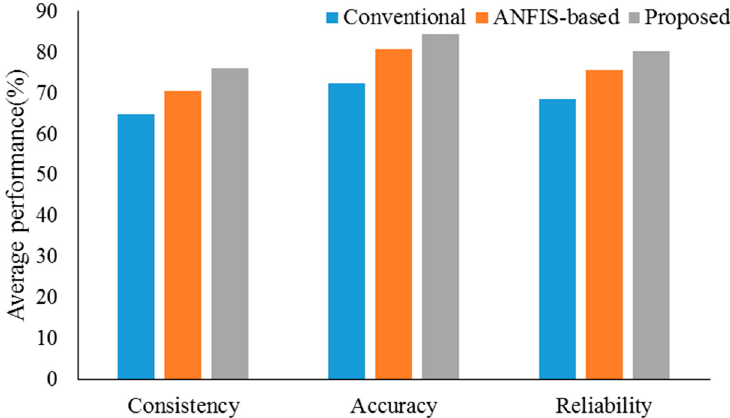
Figure 15. Results for the study by Kari (2018) [93].